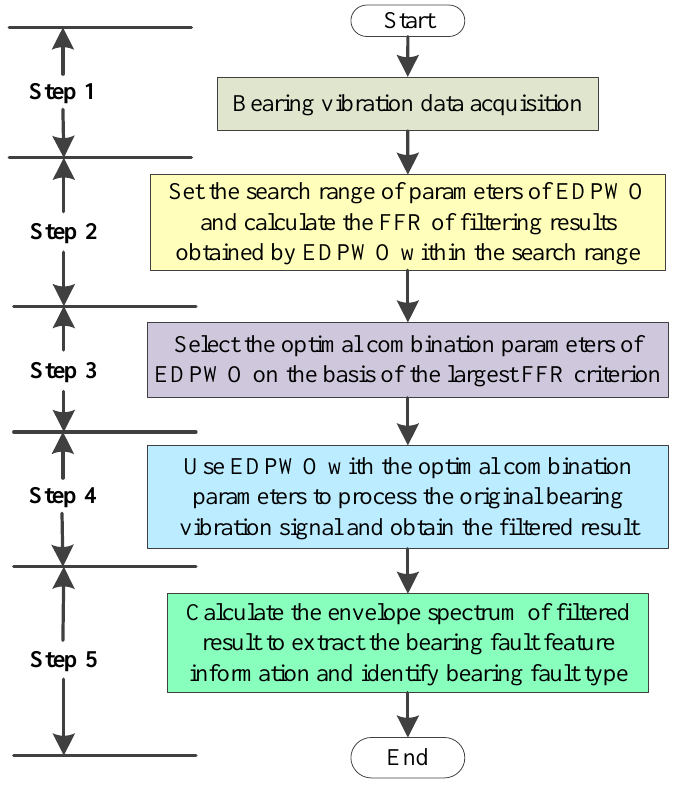
Figure 1. The flow chart of the proposed method for bearing fault feature extraction.